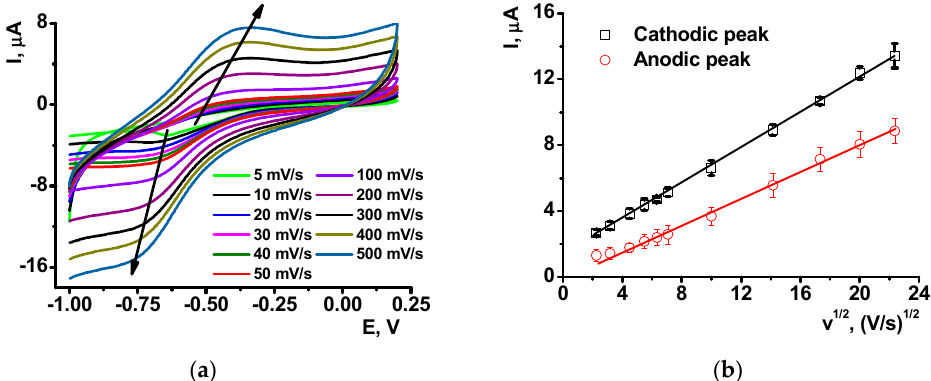
Figure 3. Cyclic voltammograms recorded on glassy carbon electrode covered with poly-NR-DNA coating ( a ) and dependence of the cathodic and anodic peak currents on the square root from the scan rate ( b ). Results are mean ± SD from six repetitions.